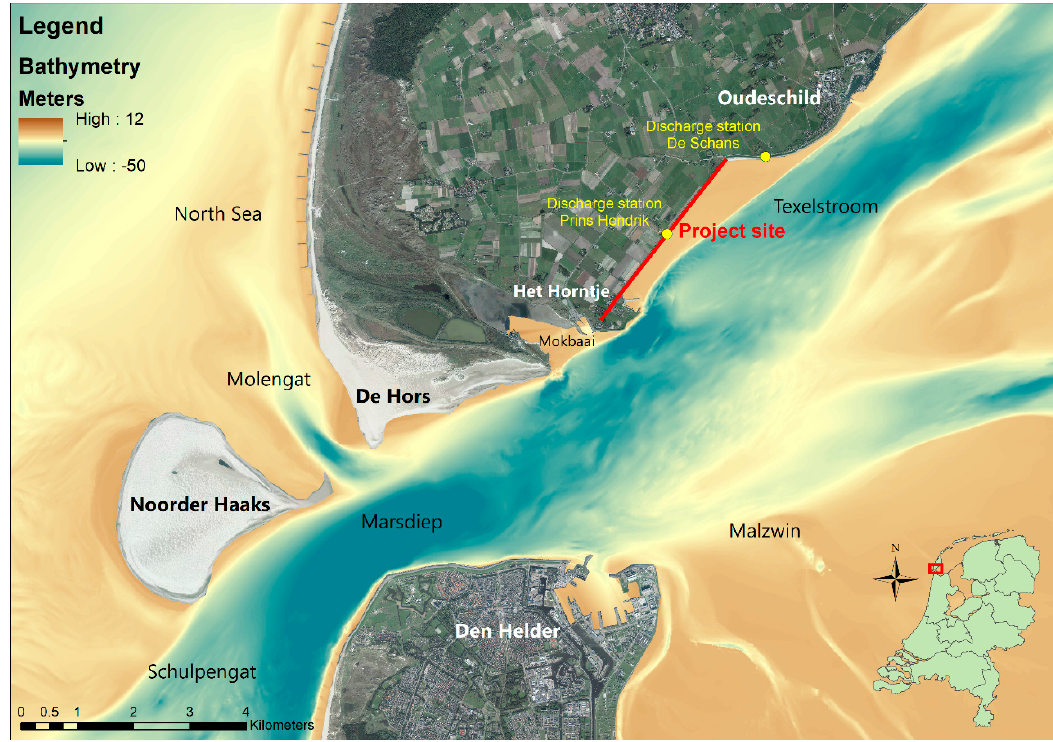
Figure 3. Location new sand dike/dune including the old Prins Hendrik dike.